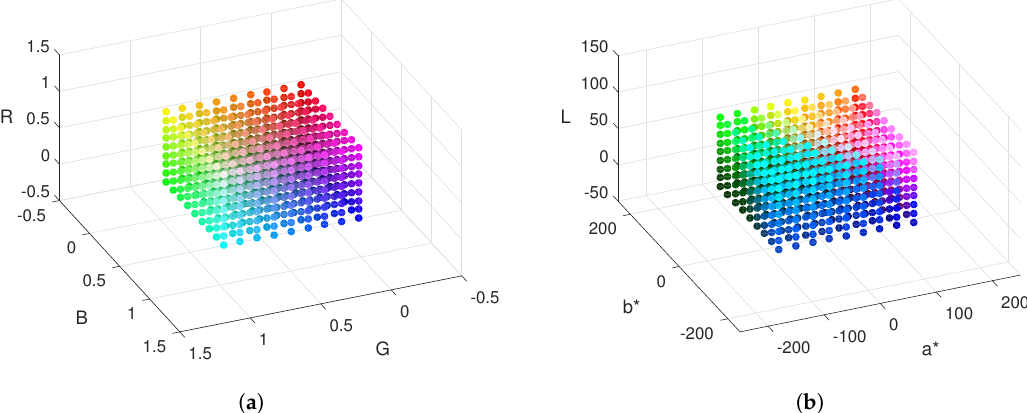
Figure 11. Color spaces used in the study: ( a ) RGB space used to display color images resulting from the proposed processing, ( b ) Lab space used to evaluate the results